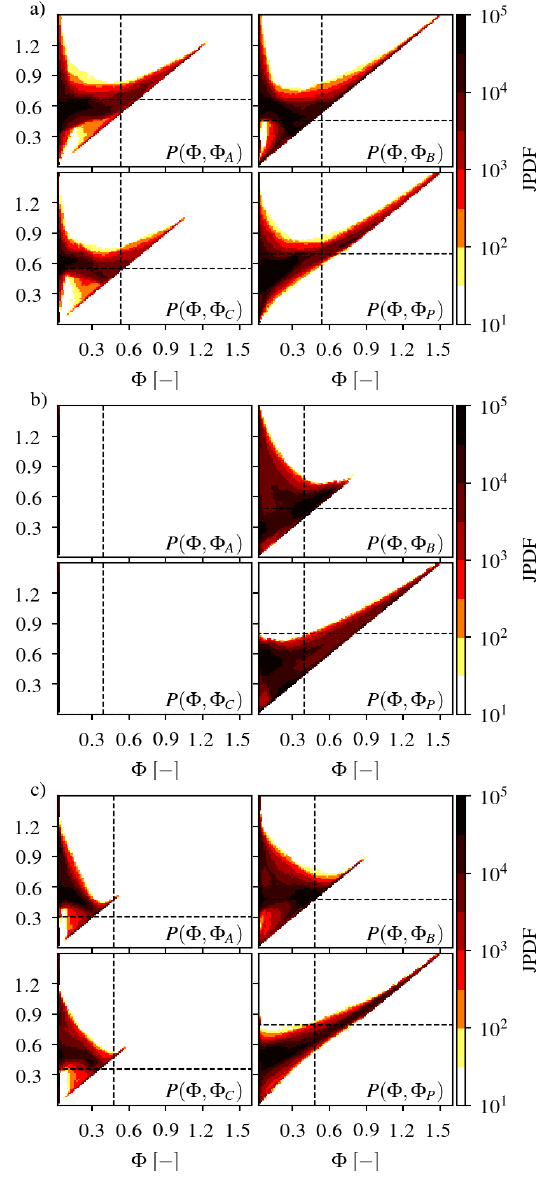
Figure 7. Joint PDF of the equivalence ratio Φ and the equivalence ratio of the individual stages Φ A , Φ Φ Φ B , P for cases ( a ) 1, ( b ) 2, and ( c ) 3. Vertical and horizontal dashed lines mark nominal C and global ( Φ glob ) and fuel stage equivalence